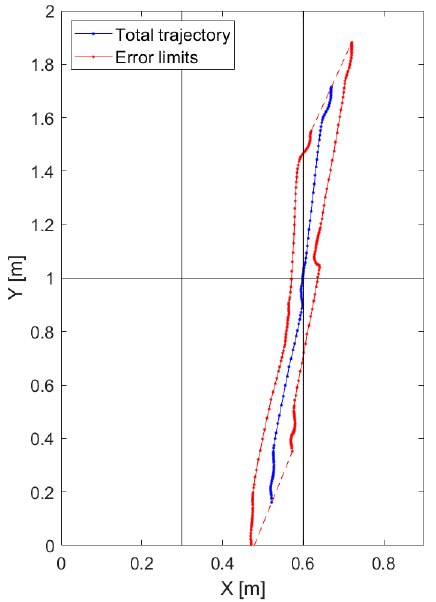
Figure 3. Simulated trajectory (blue) on a 2 × 0.9 m 2 footboard with error band (red).